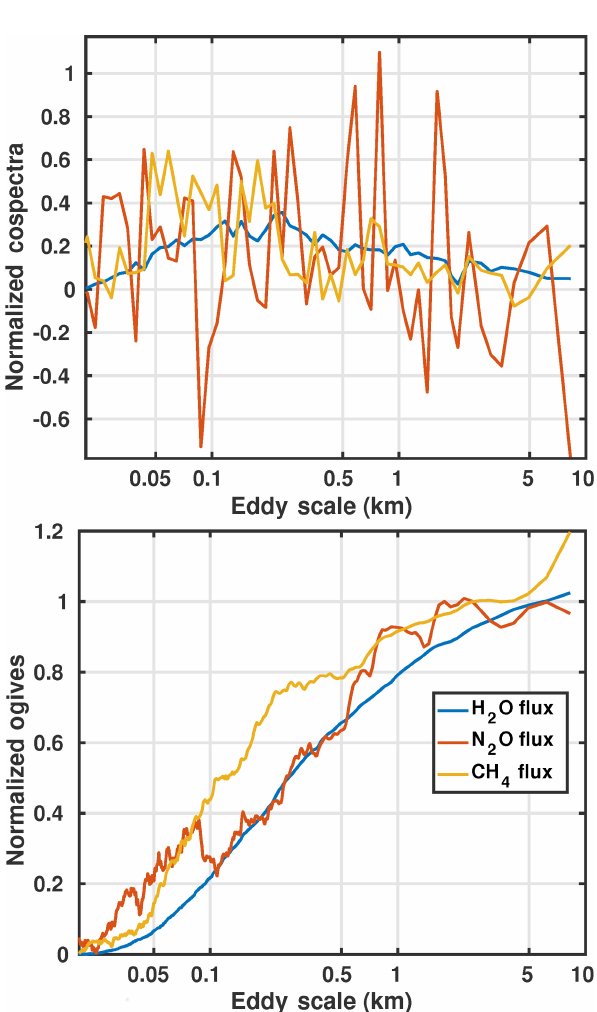
Figure 5. Normalized average cospectra and ogives for the H 2 O flux, N 2 O flux, and CH 4 flux. The average covers the entire flight campaign. The ogive integration starts from the smallest eddy